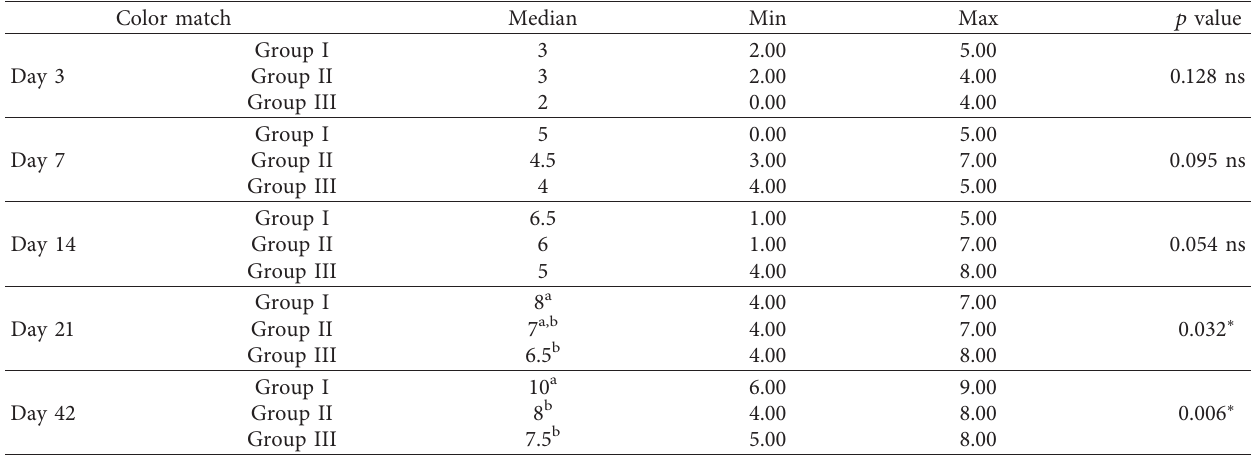
Table 4: Median and range values for the intergroup comparison of color match measured by the Visual Analogue Scale score between the three studied groups at all time